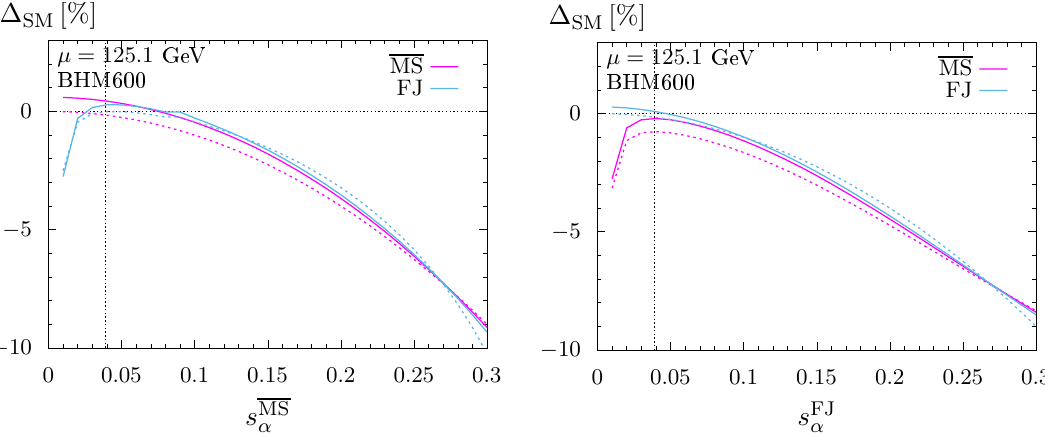
Figure 20 . Deviation of the LO and NLO decay widths (cid:0) h ! 4 f in the SESM from the SM values, as a function of s (cid:11) . Free parameters other than s (cid:11) are (cid:12)xed according to benchmark scenario BHM600 (see table 2). The vertical dashed line signals that for s (cid:11) . 0 : 04 perturbativity problems might